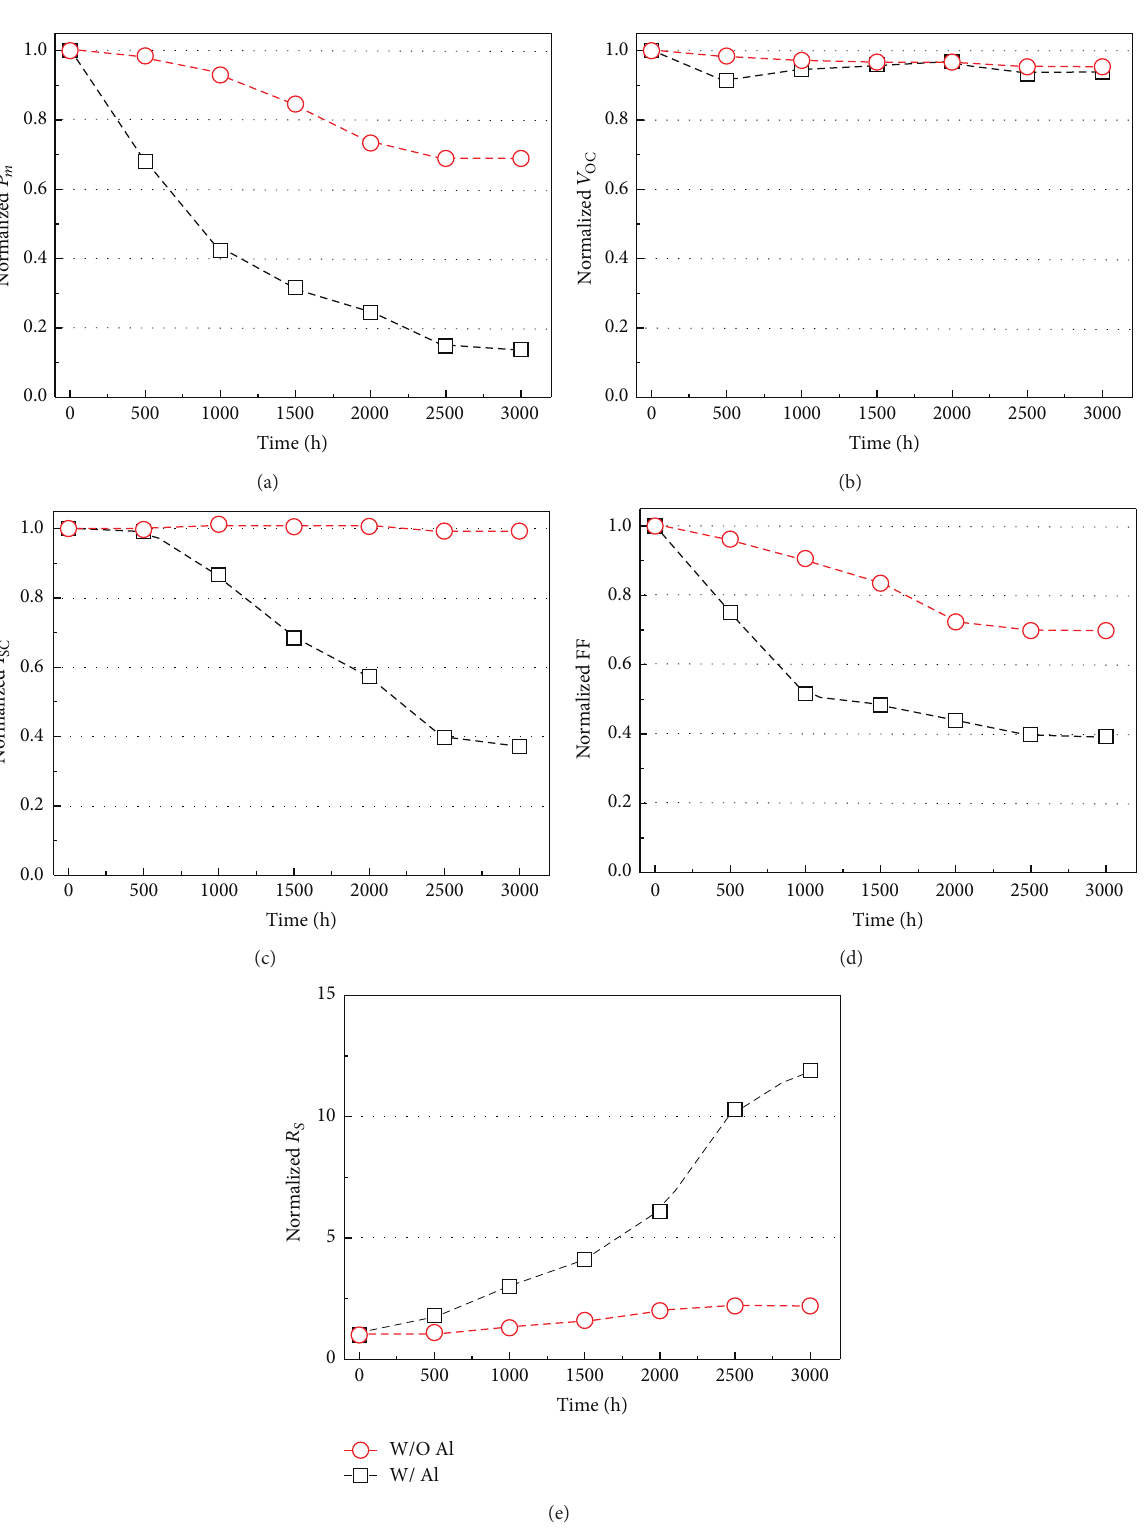
Figure 7: Change in average normalized electrical parameters of an unlaminated PV cell: (a) average maximum power ( 𝑃 𝑚 ), (b) open-circuit ), (c) short-circuit current ( 𝐼 ), (d) fill factor (FF), and (e) series resistance ( 𝑅 𝑆 voltage ( 𝑉 OC SC